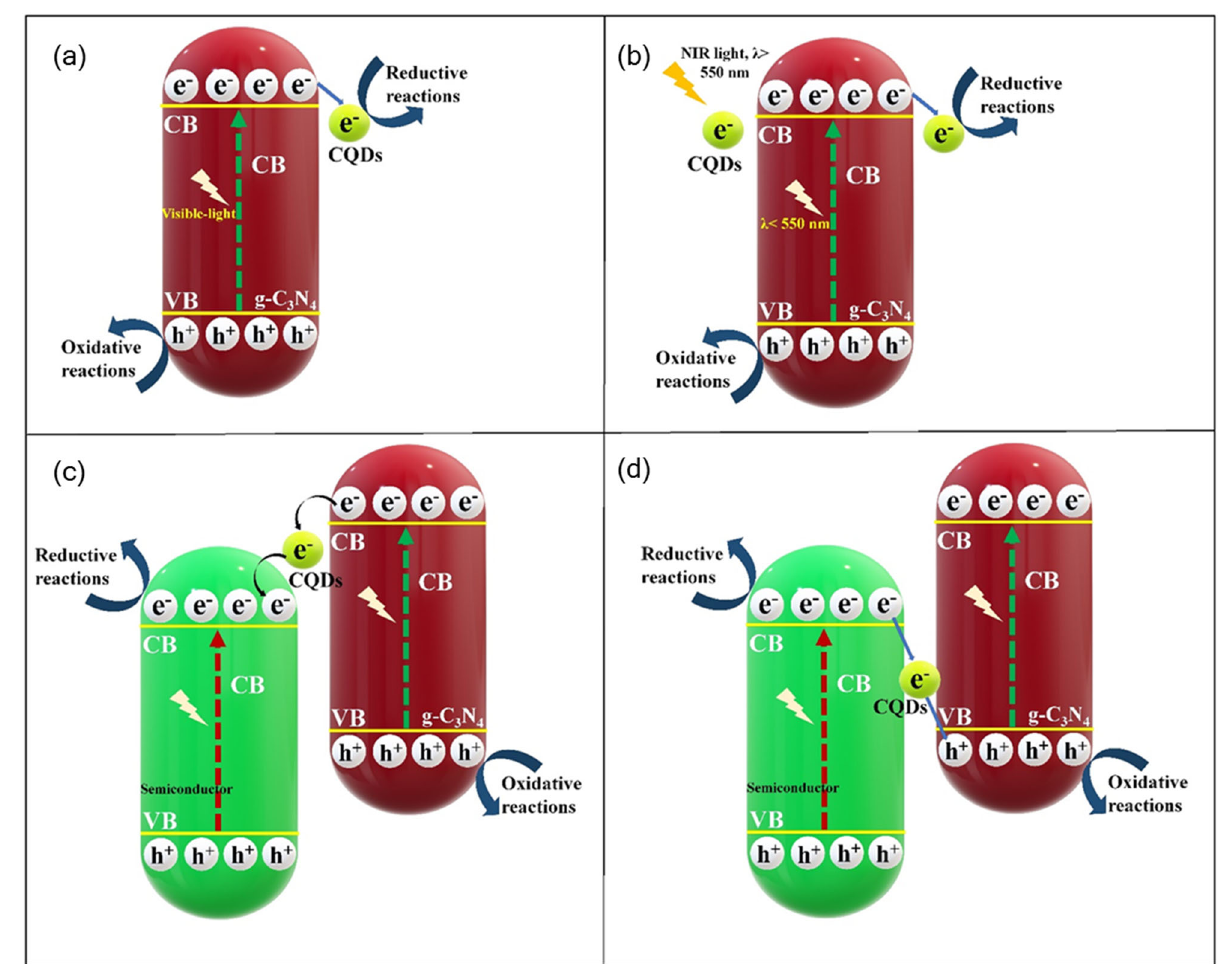
Figure 3. Schematic representation of the role of CQDs in the g ‐ C 3 N 4 /CQDs ‐ based nanocomposite, ( a ) CQDs hampers electron ‐ hole pair recombination, ( b ) CQDs enables photoexcitation of electrons ( a ) CQDs hampers electron-hole pair recombination, ( b ) CQDs enables photoexcitation of electrons even with 550 nm incident light, CQDs serve as electron mediator in ( c ) type ‐ II, and ( d ) Z ‐ schemes. even with 550 nm incident light, CQDs serve as electron mediator in ( c ) type-II, and ( d ) Z-schemes. Adapted from Ref. [23] . Adapted from Ref.